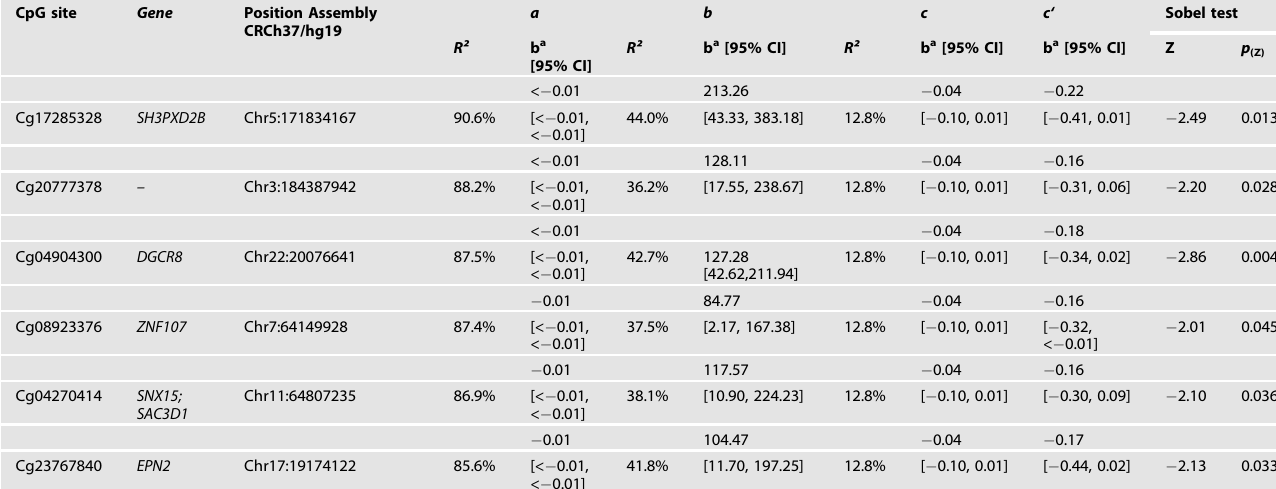
Table 5. Mediating effects of CpG methylation for association between self-reported cannabis use and VLMT free recall trial. CpG site Gene